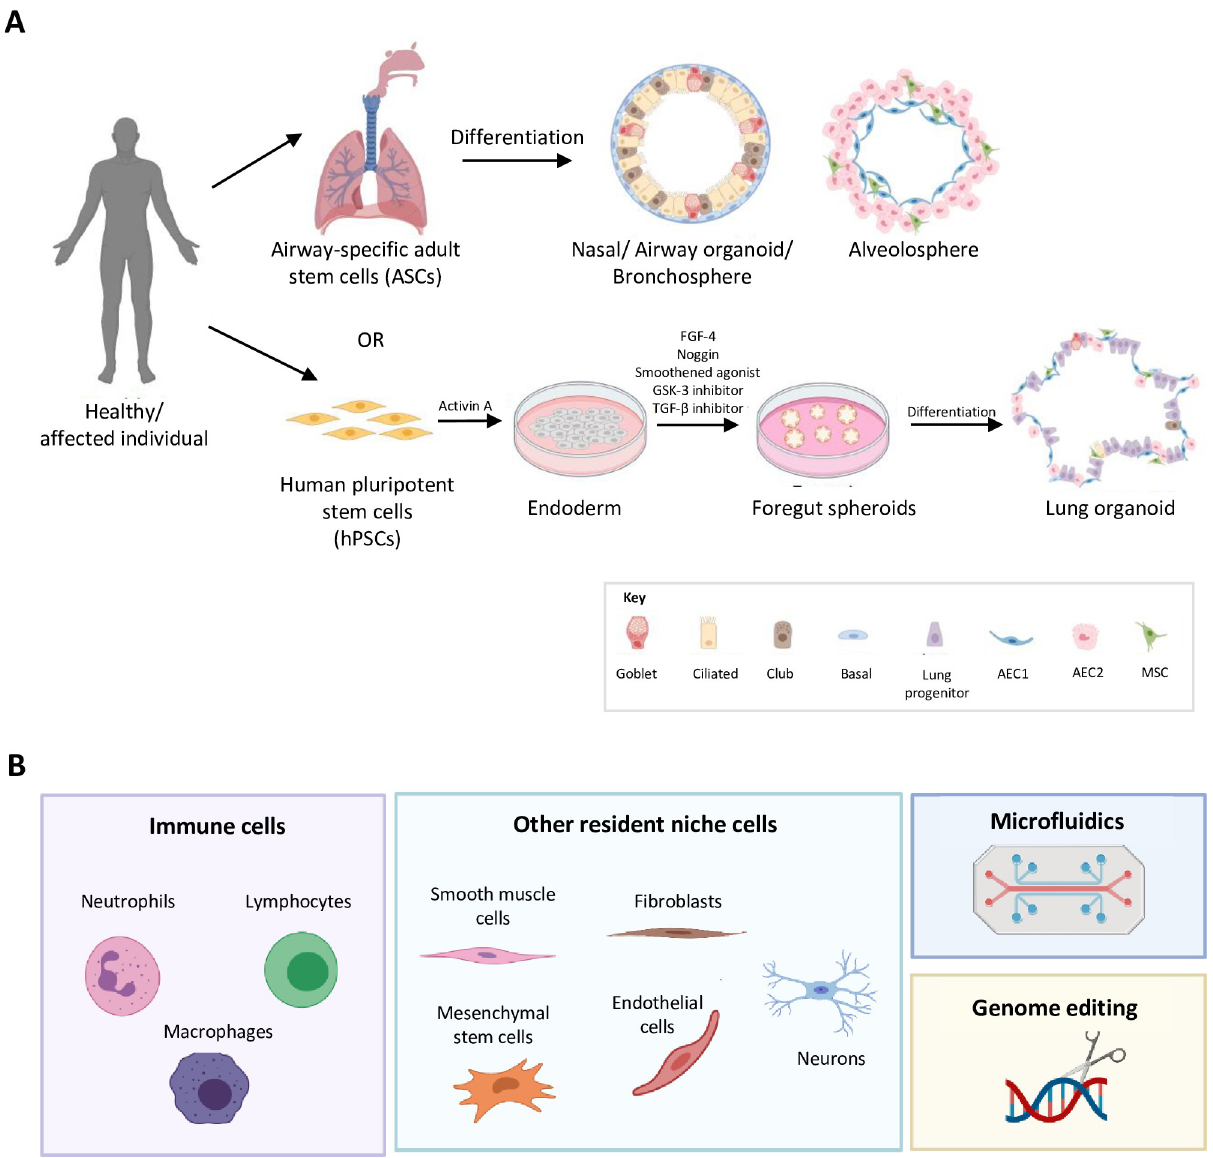
Fig 2. Airway organoids are 3D models that are valuable to bridge the knowledge gap between 2D cell line and animal models. (A) Generation of airway organoids from ASCs and hPSCs. ASCs-derived airway organoids (top panel). Tissue-resident adult stem cells can be isolated from healthy individual or patients’ airway samples and differentiated into functional epithelial cell types to form bronchospheres/nasal/airway organoids and alveolospheres with the presence of mesenchymal stem cells. hPSCs-derived lung organoids (bottom panel). Differentiation of hPSCs into endoderm by activin A and then to anterior foregut spheroids through the activation and inhibition of various signaling pathways. Foregut spheroids further differentiate into lung organoids with proximal and distal-like domains that closely resemble the lung morphology and functions. Key: FGF-4 (fibroblast growth factor 4); GSK3 (glycogen synthase kinase 3); TGF- β (transforming growth factor beta 1); AEC1 (alveolar epithelial type I cells); AEC2 (alveolar epithelial type II cells); and MSC (mesenchymal stem cell). (B) Future development of next-generation airway organoids. Organoids- on-a chip allows the co-culture of multiple cell types and generation of 3D multicellular structures to better model the functional units of an organ, while replenishment of nutrients and removal of wastes can be done in a controlled manner through microfluidics system. Modification of organoids using advanced gene editing techniques such as CRISPR-Cas9 can be useful for studying virus–host interactions such as deciphering signaling pathways implicated in SARS-CoV-2 pathogenesis or identifying host proteins utilized by viruses in causing infection. Current versions of airway organoids are simplified forms of the native tissue. Incorporation of immune cells and other resident niche cells can highly enhance the biomimicry of the existing airway organoids. Created with BioRender.com. ASC, adult stem cell; hPSC, human pluripotent stem cell; SARS-CoV-2, Severe Acute Respiratory Syndrome Coronavirus 2; 2D, two-dimensional; 3D, three-dimensional.